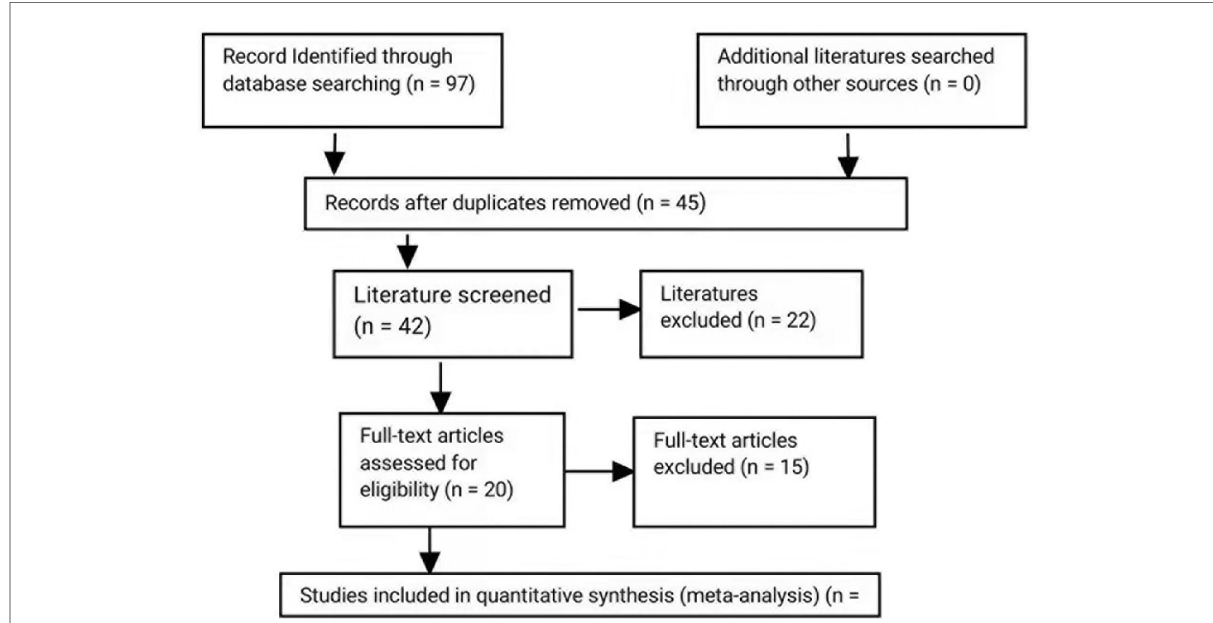
FIGURE 1 Flow chart of studies included and